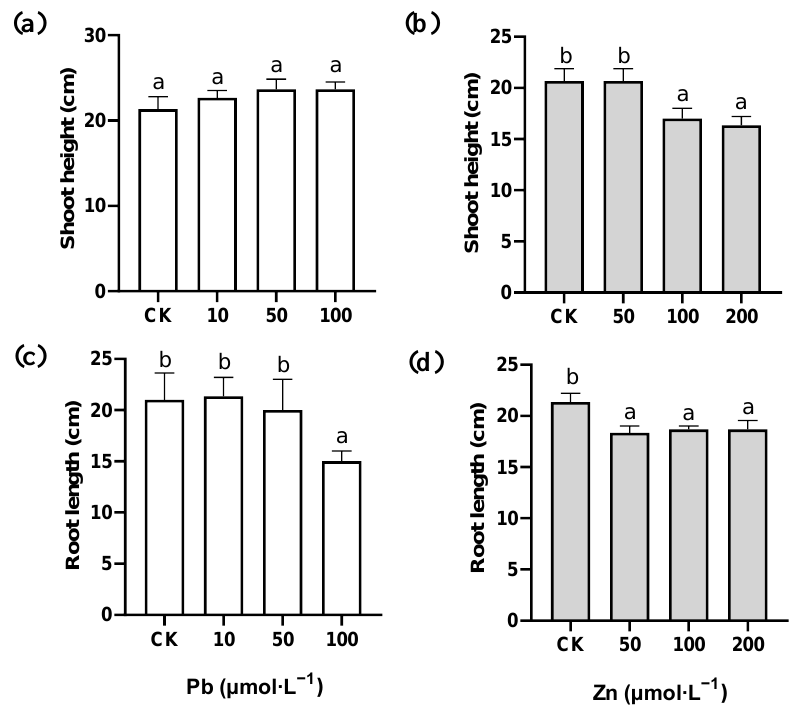
Figure 1. Shoot height ( a , b ) and root length ( c , d ) of M. cordata grown hydroponically under control (CK) and varied concentrations of Pb and Zn for seven days . Values are means ± SE ( n = 3) with three separate replicates. Means denoted by different letters refer to the significant differences ( p < 0.05, Duncan’s test).